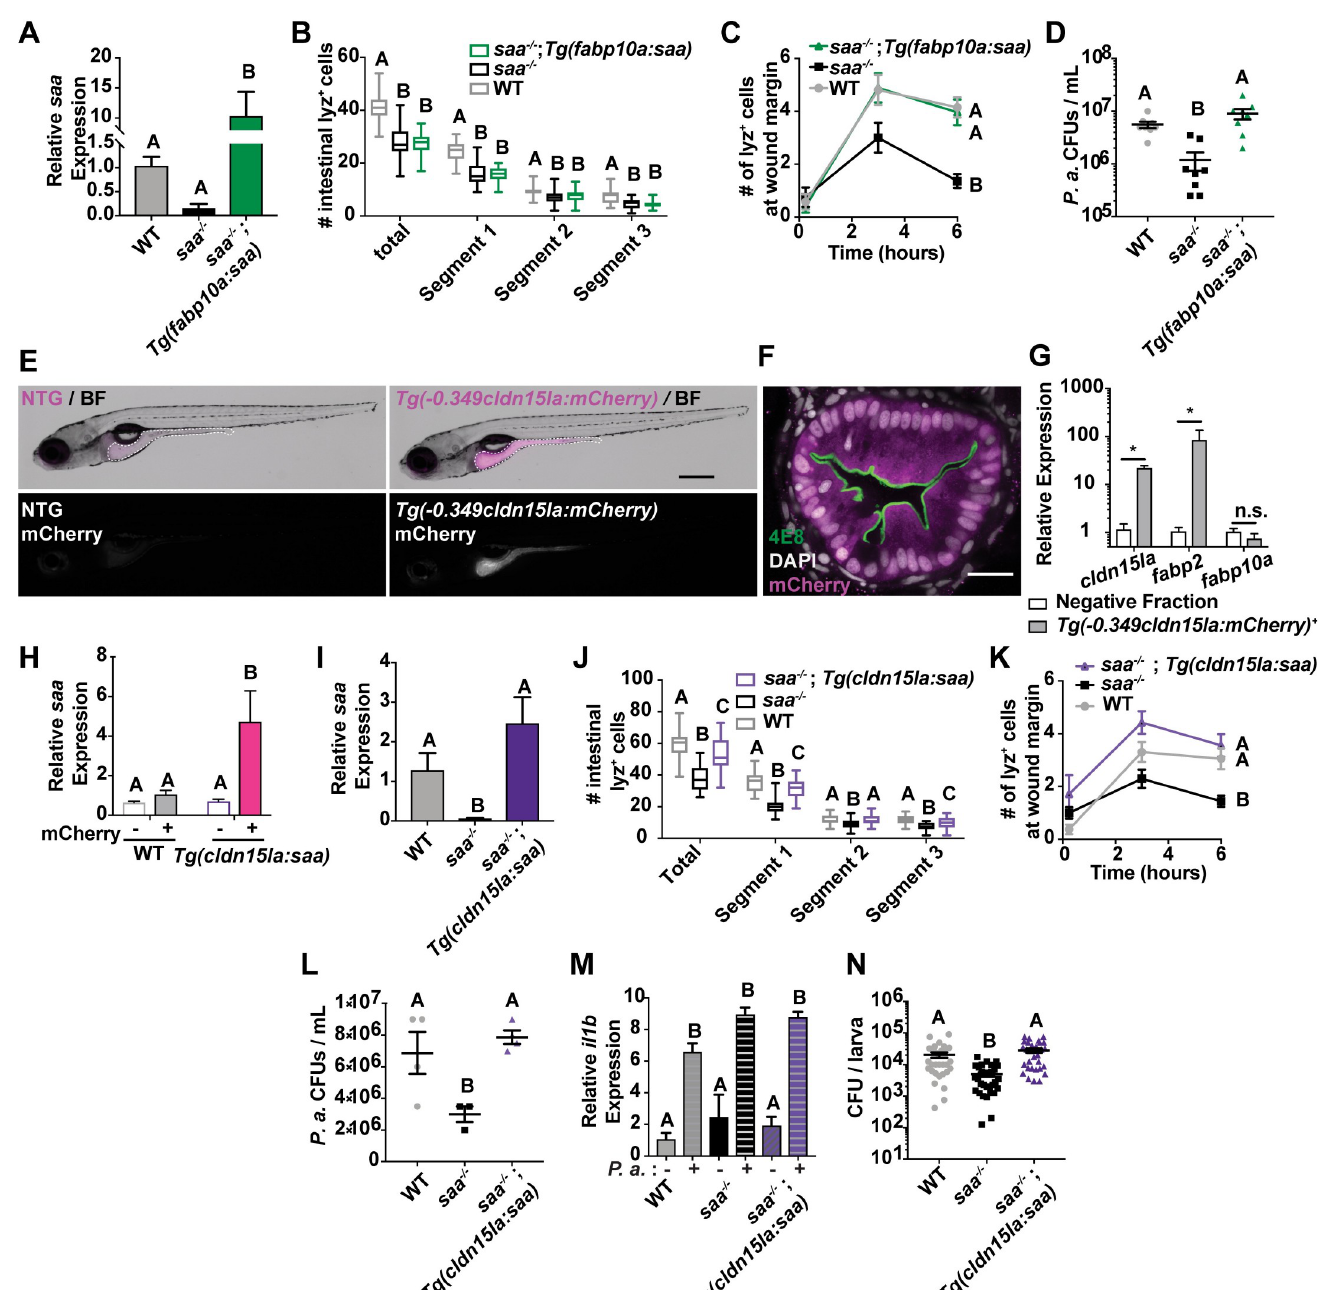
Fig 4. Intestinally-derived Saa regulates systemic neutrophil activity. (A) qRT-PCR of saa from whole 6 dpf larvae of the indicated genotypes (n = 4 replicates / genotype, 25–30 larvae / replicate) (B) Enumeration of intestine-associated lyz:DsRed + neutrophils along the anterior to posterior axis (segment 1 to segment 3) in 6 dpf larvae (n � 25 larvae / genotype). (C) lyz:DsRed + neutrophil recruitment to caudal fin wound 6 hours following amputation in 6 dpf zebrafish larvae (n � 25 larvae / genotype at 6 hour time point). (D) CFU quantification of bacterial concentration following 4 hour co-culture of lyz:DsRed + adult zebrafish neutrophils with P . aeruginosa ( P . a ., MOI 0.2) (8 replicates / genotype). (E) Representative stereoscope images of IEC specific mCherry expression in 6 dpf Tg(-0 . 349cldn15la : mCherry) rdu65 larvae compared to non-transgenic (NTG) controls. White dashed line indicates the intestine (scale bar = 500 μ m). (F) Representative confocal micrograph of immunostained transverse section of Tg(-0 . 349cldn15la : mCherry) 6 dpf larvae labeled with the absorptive cell brush border-specific antibody 4E8 (scale bar = 20 μ m). (G,H) qRT-PCR of cldn15la , fabp2 , and fabp10a (G) from sorted Tg(-0 . 349cldn15la : mCherry) + IECs and saa (H) from cldn15la : mCherry + and negative cells isolated from 6 dpf larvae of indicated genotypes (13,000 –0.349cldn15la:mCherry + or mCherry negative cells / replicate, 4 replicates / genotype, 30 larvae / replicate). (I) qRT-PCR of saa from 6 dpf larval dissected digestive tissue of the indicated genotypes (n = 4 replicates / genotype, 25–30 larvae / replicate) (J) Enumeration of intestine-associated lyz:DsRed + neutrophils in 6 dpf larvae (n = 30 larvae / genotype). (K) lyz:DsRed + neutrophil recruitment to caudal fin wound 6